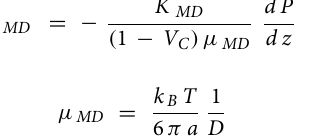
Fig. 1b. Figure 2 shows the theoretical curve of the term representing the van der Waals interaction in the intermo- lecular force field of the potential function AMBER96, where the theoretical equation is given by Eq. (5).